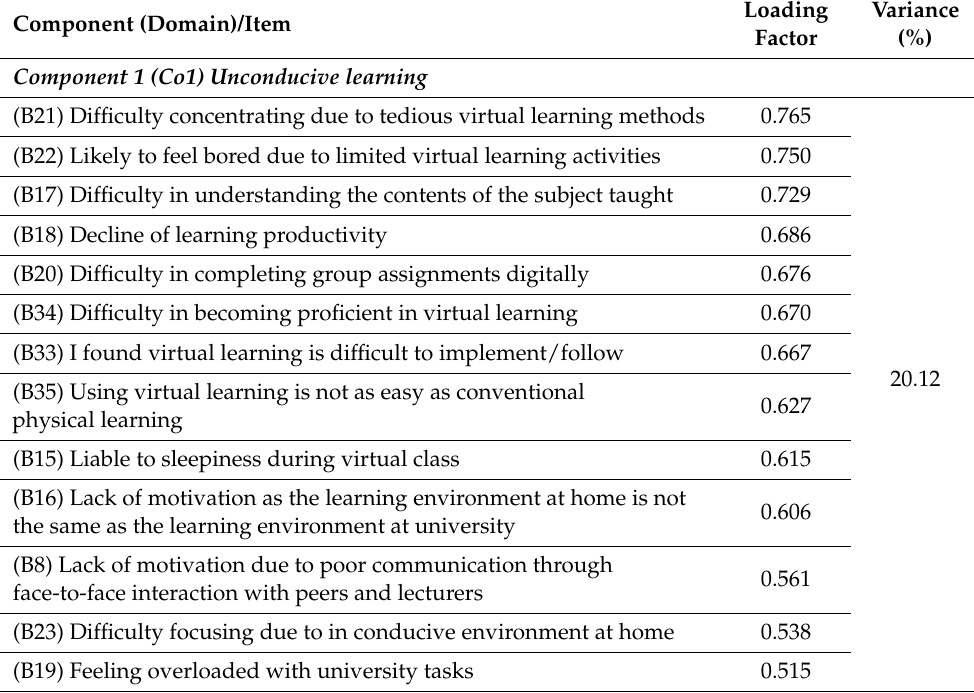
Table 3. Analysis results of main component